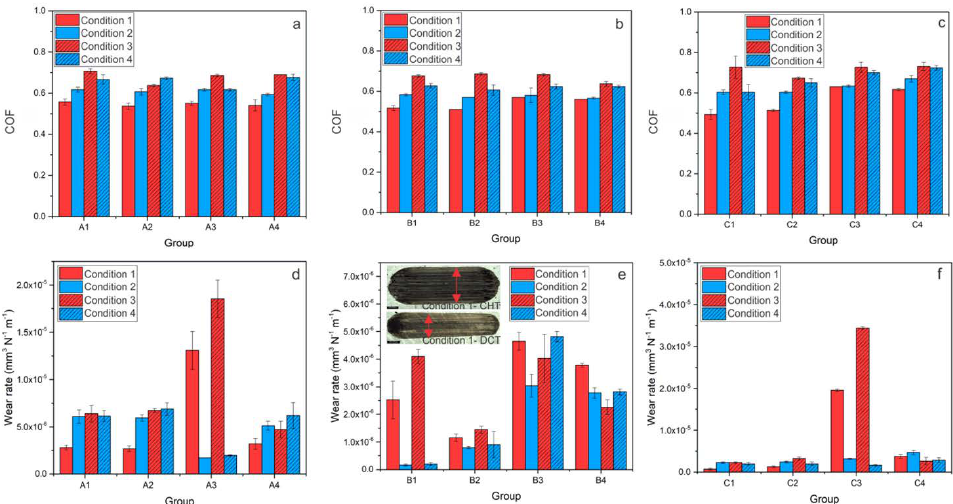
Figure 2. Results of abrasive wear conditions (Al 2 O 3 counter-body) for all three steels; A (AISI M2), B (AISI M3:2) and C (AISI M35), where ( a – c ) is steady-state coefficient of friction for each condition and ( d – f ) is wear rate for each steel at certain condition. ( e ) the insert shows the average representation of wear scar for all three steels of conventionally (CHT) and deep cryogenically heat-treated samples, the black scale represents 500 µ